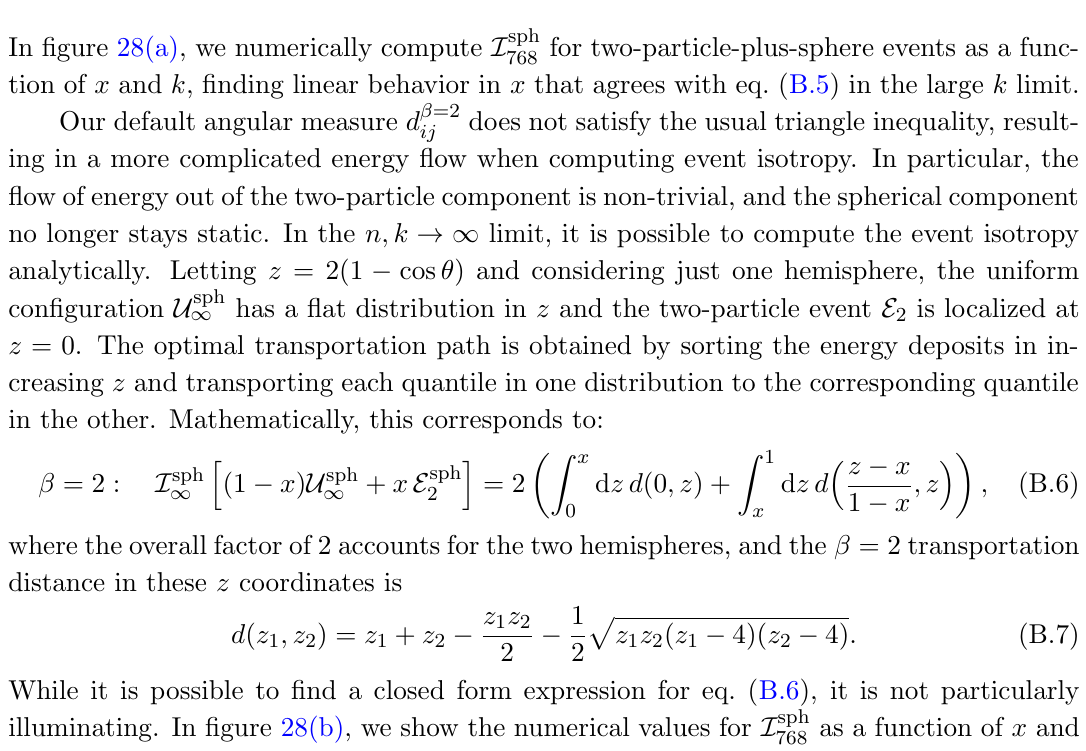
Figure 28 . Spherical event isotropy computed with (a) d (cid:12) =1 particle con(cid:12)gurations superimposed on k -particle spheres. The numerical values are computed using I sph after averaging over 10 2 random orientations, and we sweep over the fraction x of the 768 total energy allocated to the two-particle con(cid:12)guration. When using the (cid:12) = 1 measure, the event isotropy is linearly sensitive to x at large k , as computed in eq. (B.5). For the (cid:12) = 2 measure, the large k limit has a more complicated behavior, as computed in eq.